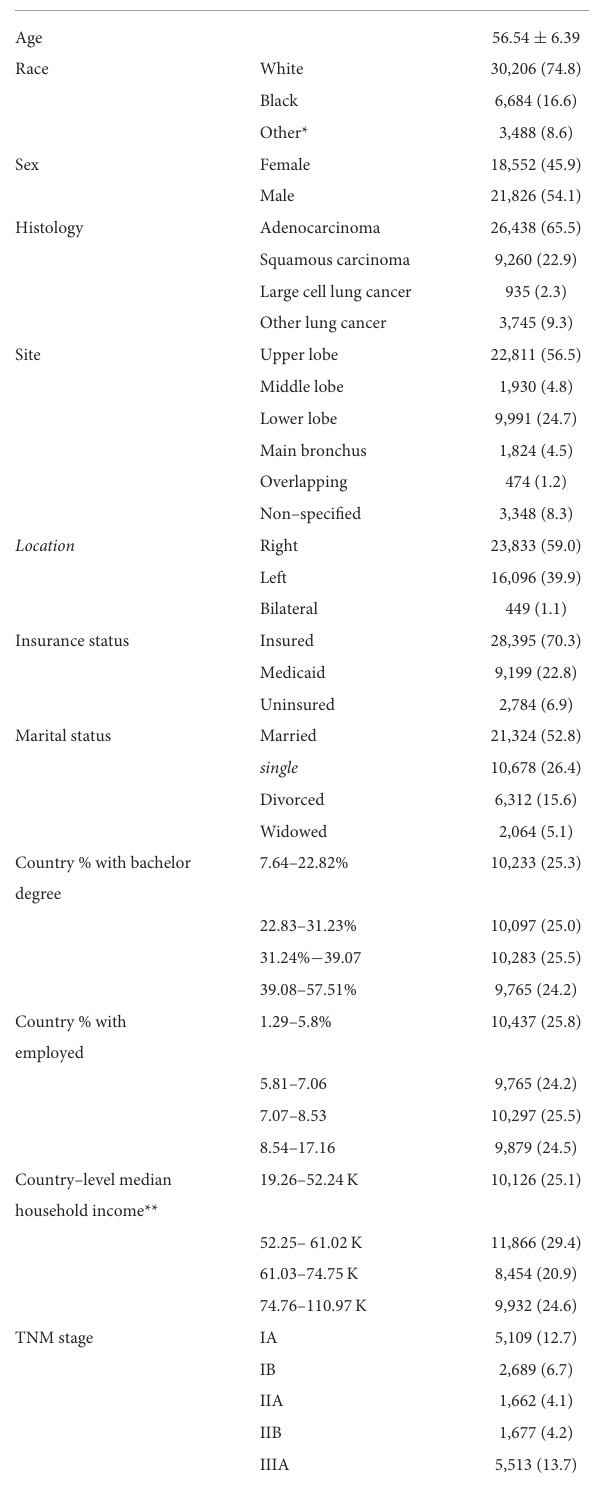
TABLE 1 The characteristics of patients with non-small cell lung cancer (NSCLC).